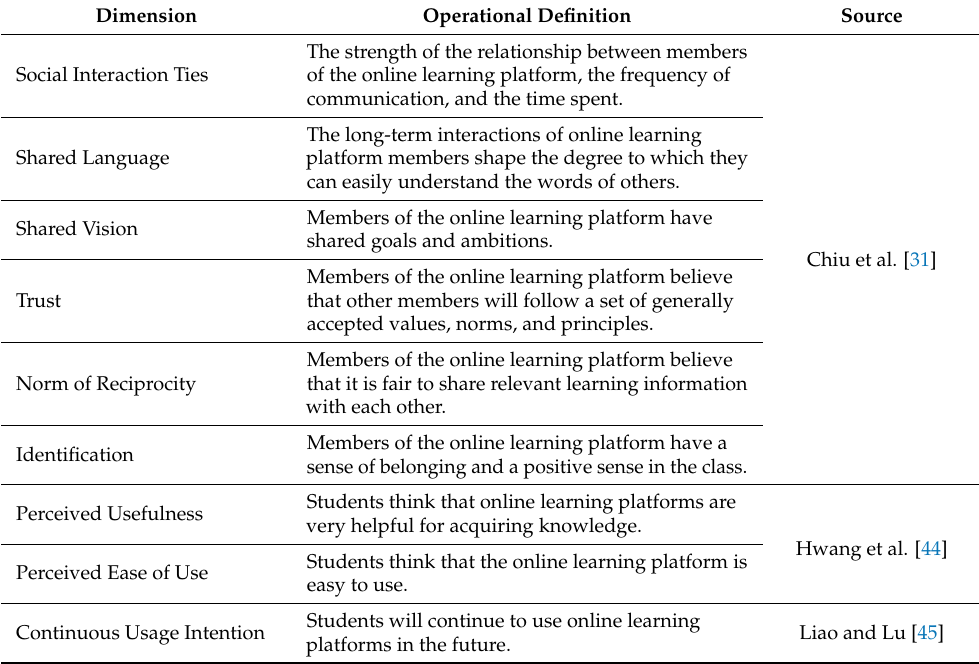
Table 1. The operational definitions and reference